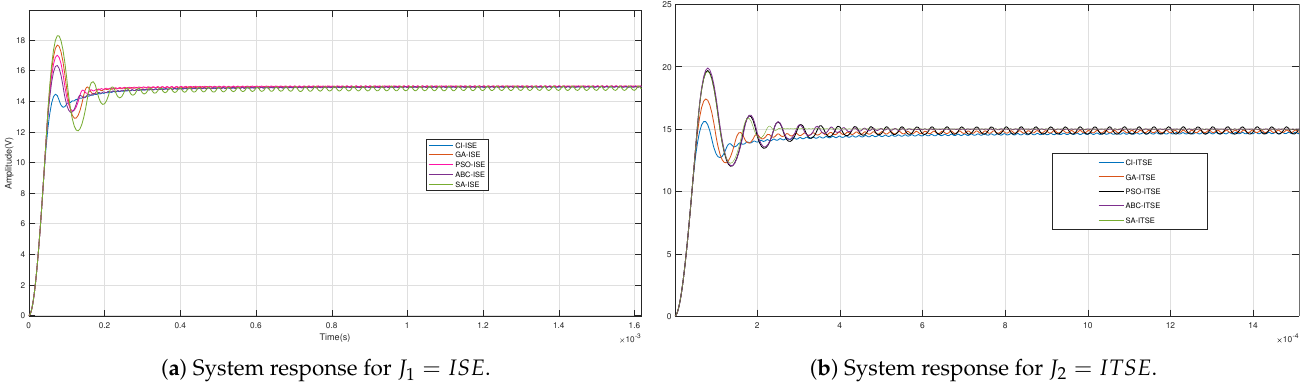
Figure 14. System response for optimization of ISE and